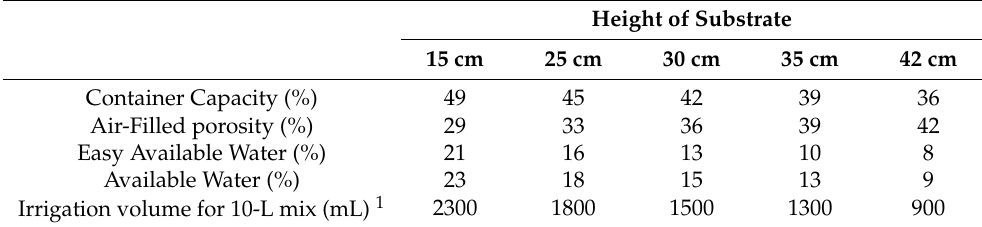
Table 1. Physical properties of a peat-based mix as a function of substrate height.